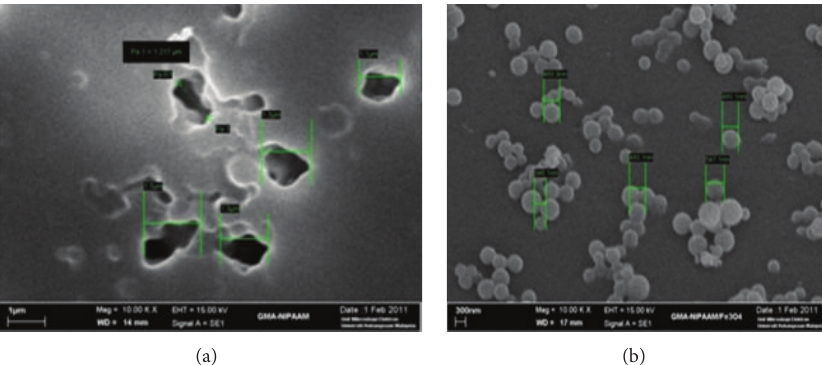
Figure 6: The micrographs for (a) copolymer beads surface without iron oxide nanoparticles and (b) distribution of beads for magnetic copolymer